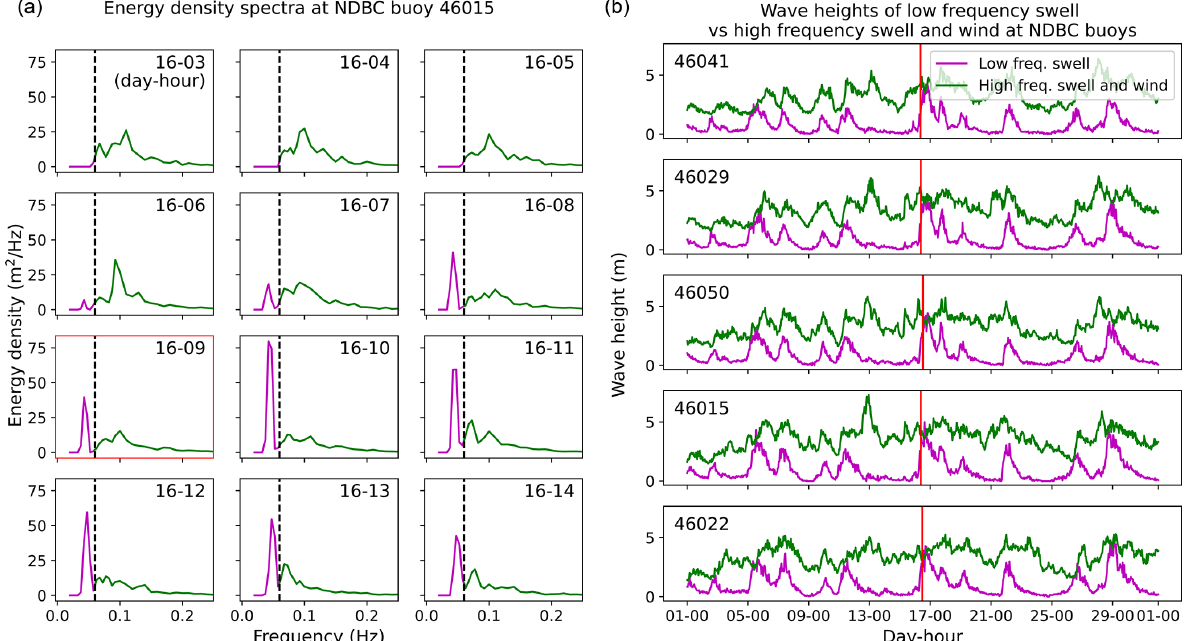
Figure 9. Ocean wave spectra (a) at NDBC buoy 46015 on 16 January 2016 from 03:00 to 14:00. Vertical dashed lines are located at a frequency of 0.06Hz and are used to separate the swell component from the wind. The red box represents 16 January, 09:00, i.e., the approximate onset of unusual water level fluctuations at the nearby tide gage. (b) Time series of significant wave height from swell and wind components calculated from the energy density spectra on 16 January. The vertical red line represents 08:33, 09:03, 12:21, 09:03, and 11:27 on 16 January from top to bottom, i.e., the approximate onset of unusual water level fluctuations at the nearby tide